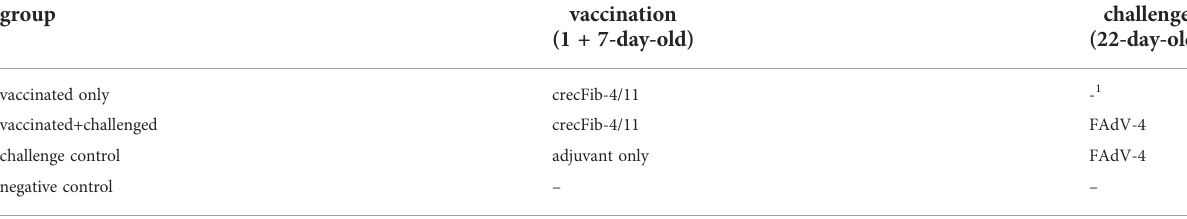
TABLE 1 Experimental groups of the protection